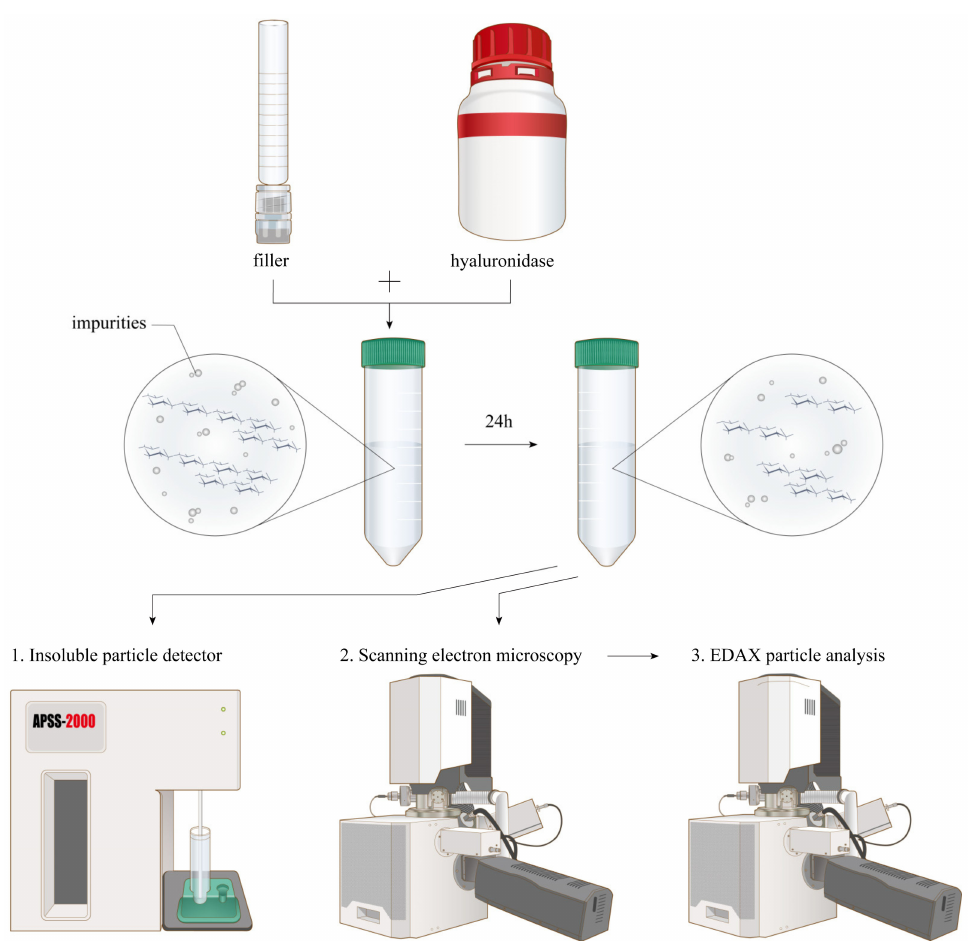
Figure 1. A representation of the impurity particle analysis process. Hyaluronic acid filler was degraded for 24 h with hyaluronidase. No visible hyaluronic acid filler particles were detected after degradation. The insoluble particles were counted, visualized using scanning electron microscopy, and analyzed using energy-dispersive X-ray